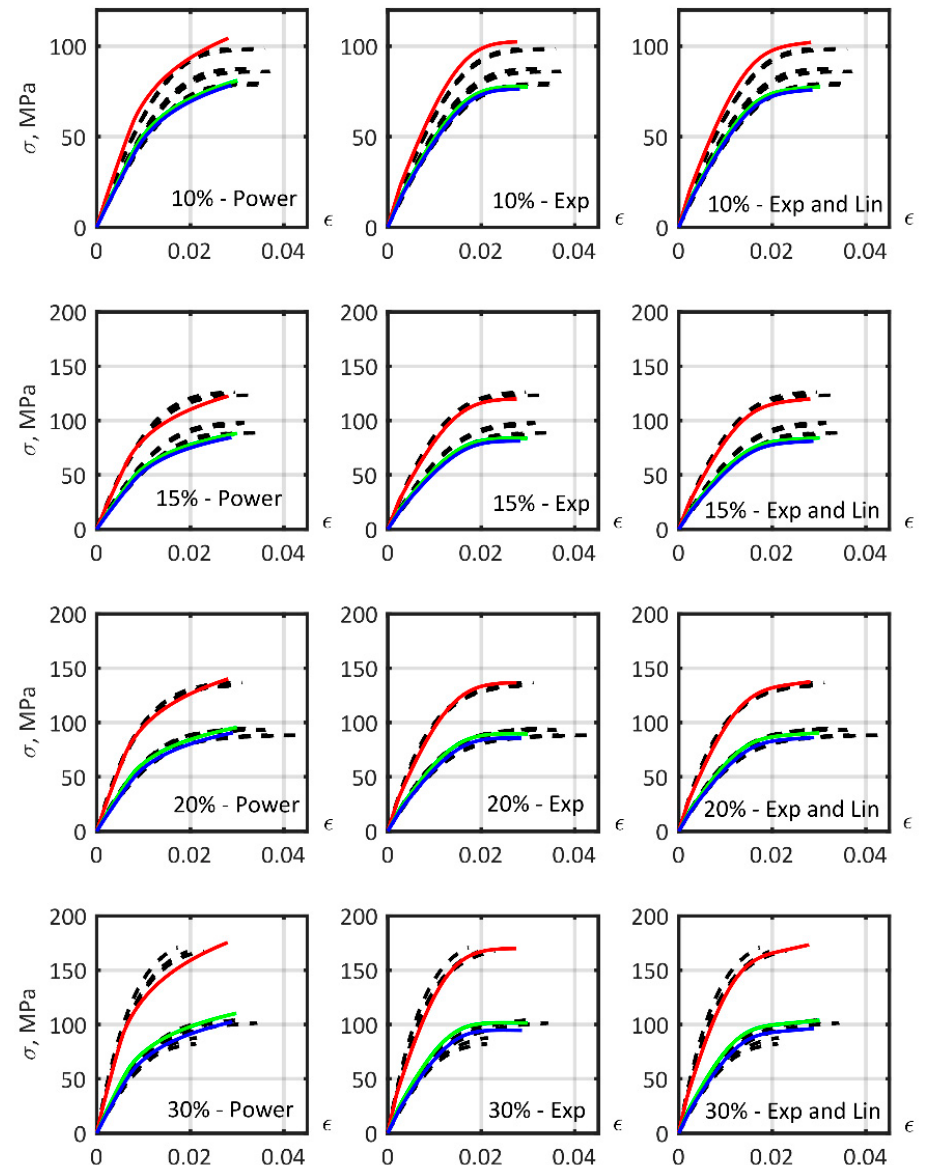
Figure 18. Stress–strain curves prepared from the mean obtained strain limits, and using Tsai–Hill 3D transversely isotropic strain-based values for 10%, 15%, 20%, and 30% fiber mass fractions. Material model—color lines: 0°—red lines, 45°—green lines, 90°—blue lines. Experimental data—black dashed lines.